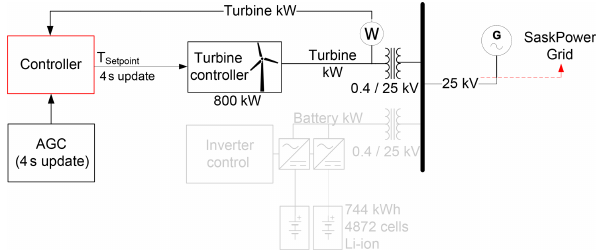
Figure 3. Single-line diagram of the Cowessess First Nations site in Regina, Saskatchewan. Note that the battery is not part of the results presented